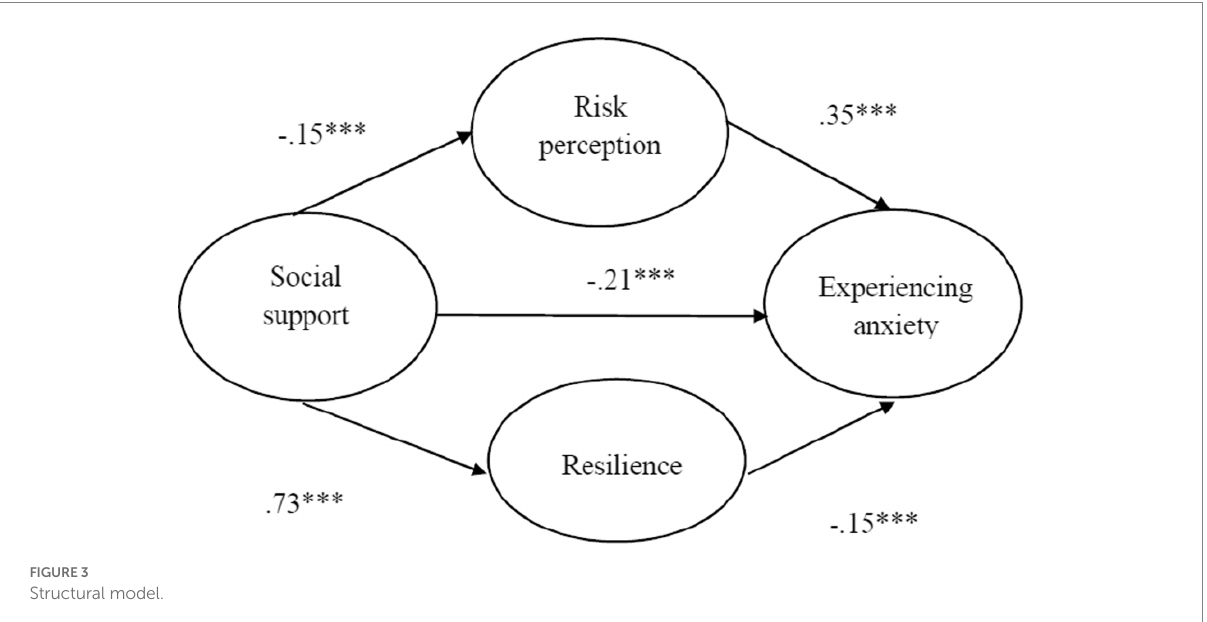
FIGURE 3 Structural